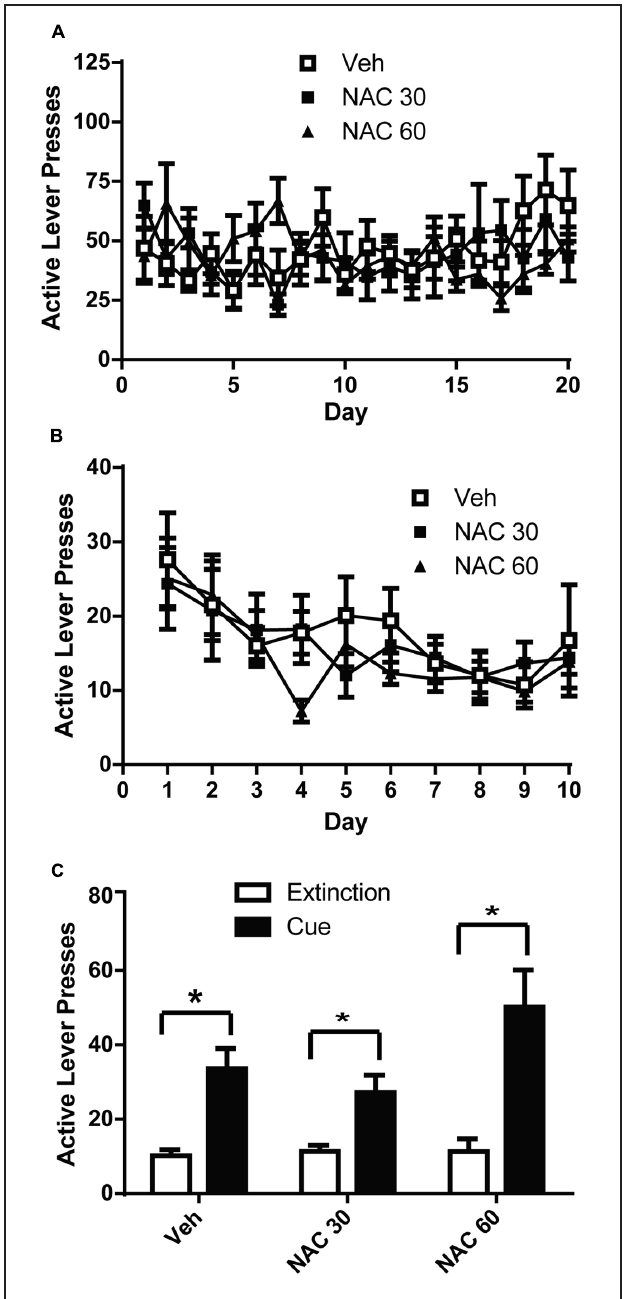
FIGURE 2 | N -acetylcysteine did not attenuate cue-primed reinstatement of alcohol-seeking. (A) Mean active lever presses during the FR3 portion of the experiment did not differ between groups. (B) Mean active lever presses during extinction training did not differ between groups. (C) N -acetylcysteine did not attenuate cue-primed reinstatement of alcohol- seeking. * p < 0.05 comparing extinction to test.